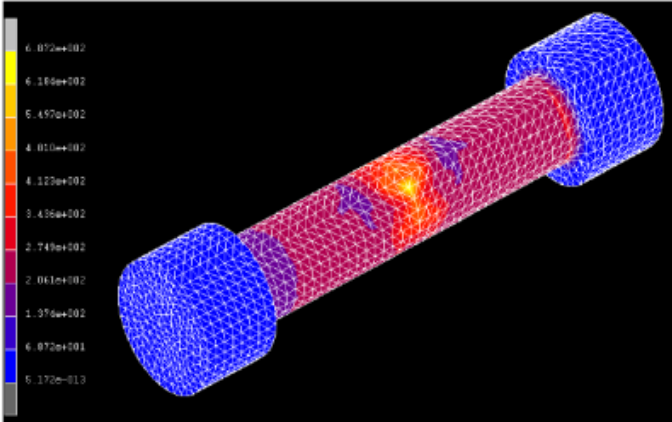
Figure 8: Stress distribution on the pivot caused by the